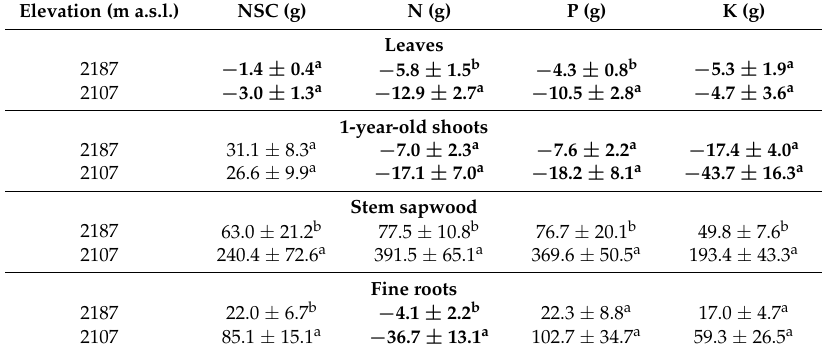
Table 4. End-season resource reallocation (mean value ± 1 standard deviation; n = 5 trees; calculated using biomass × reallocation rate) for Betula ermanii trees at 2187 m (upper limit of distribution) and 2107 m a.s.l. on Changbai Mt. Different letters display significant differences at the 0.05 level among elevations as determined by Tukey’s HSD test. Negative values (dark-highlighted) indicate resource “loss” due to resource reallocation, and positive values indicate resource “gain” because of accumulation. Elevation (m a.s.l.) NSC (g) N (g) P (g) K (g) Leaves 2187